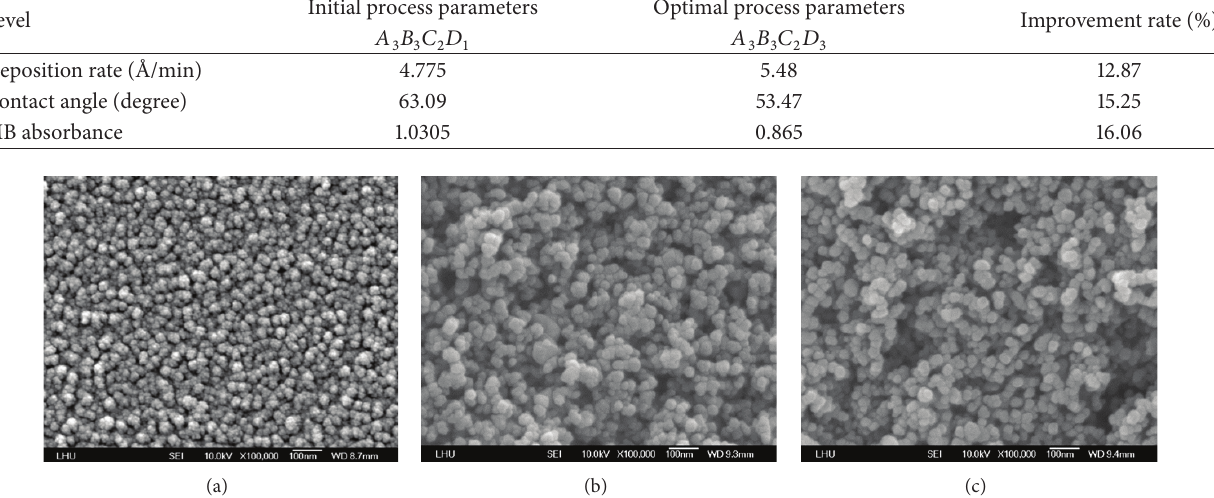
Figure 3: (a) The SEM images for sputtered TiO 2 compact layer on ITO/glass, (b) the SEM images for porous TiO 2 onto TiO 2 compact/ITO/glass, produced using the sol-gel with spin coating method, and (c) the SEM images for porous TiO 2 onto TiO 2 compact/ITO/glass, produced using the sol-gel with blade coating method.